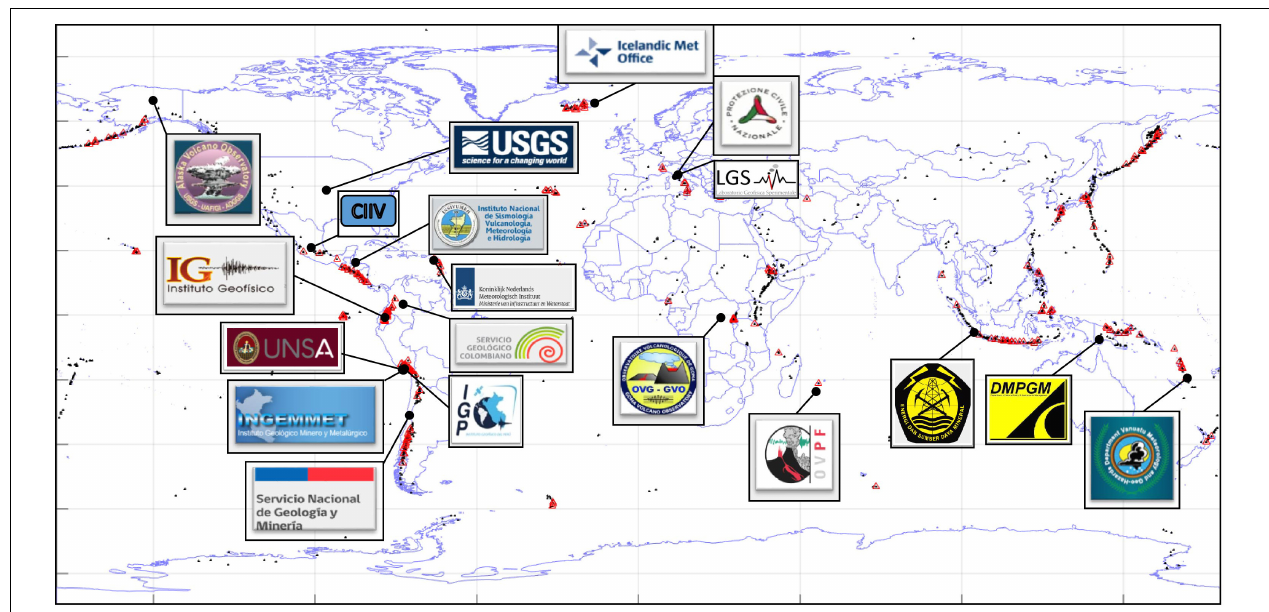
FIGURE 6 | Volcanoes currently observed by MIROVA (red triangles) with distribution of observatories (logos within insets) that use MIROVA in support of monitoring activities (see Supplementary Table S2 for details).